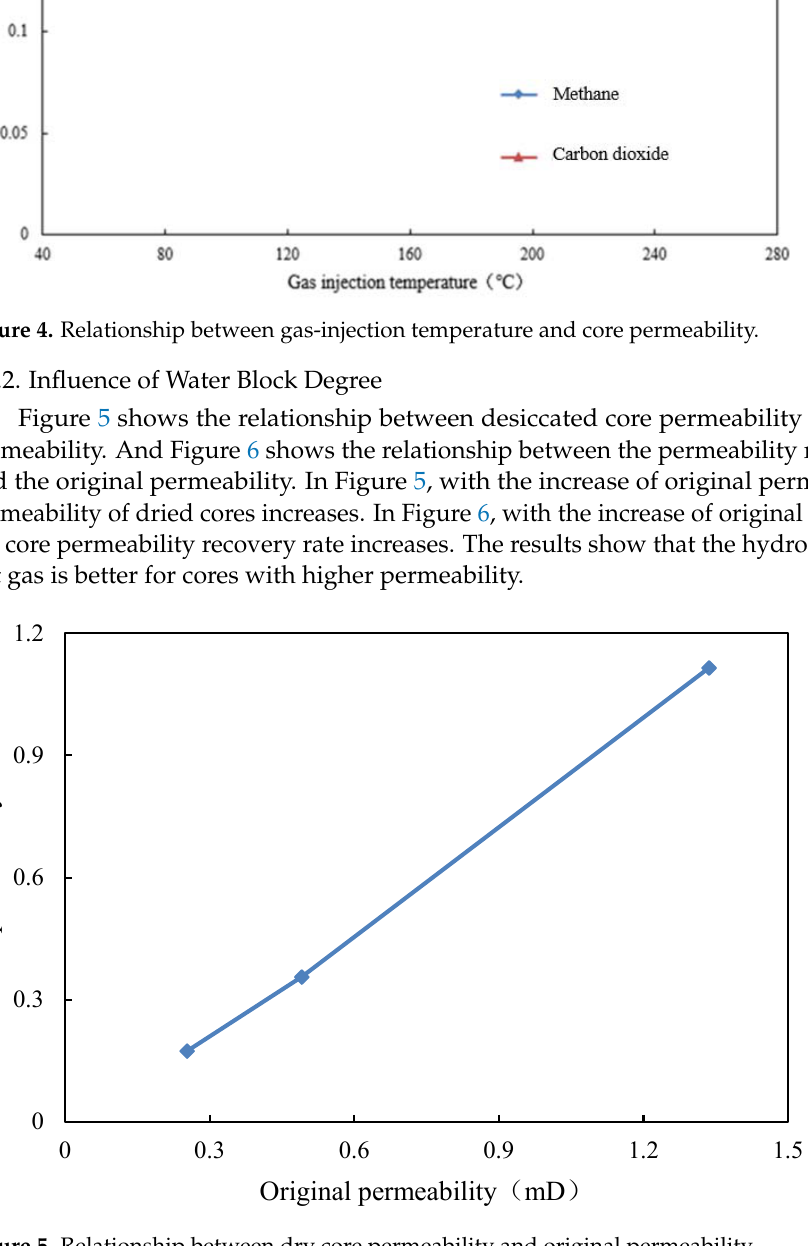
Figure 6. Relationship between permeability recovery rate and original permeability. 3. Numerical Simulation of Hot-Gas Injection After the feasibility of hot-gas injection, the water lock is studied experimentally, and the concrete influence of hot-gas injection water lock is further studied by numerical simulation. The simulation has been conducted by using the commercial finite element simulation software COMSOL. The model’s hypotheses and boundary conditions are as follows: (1)